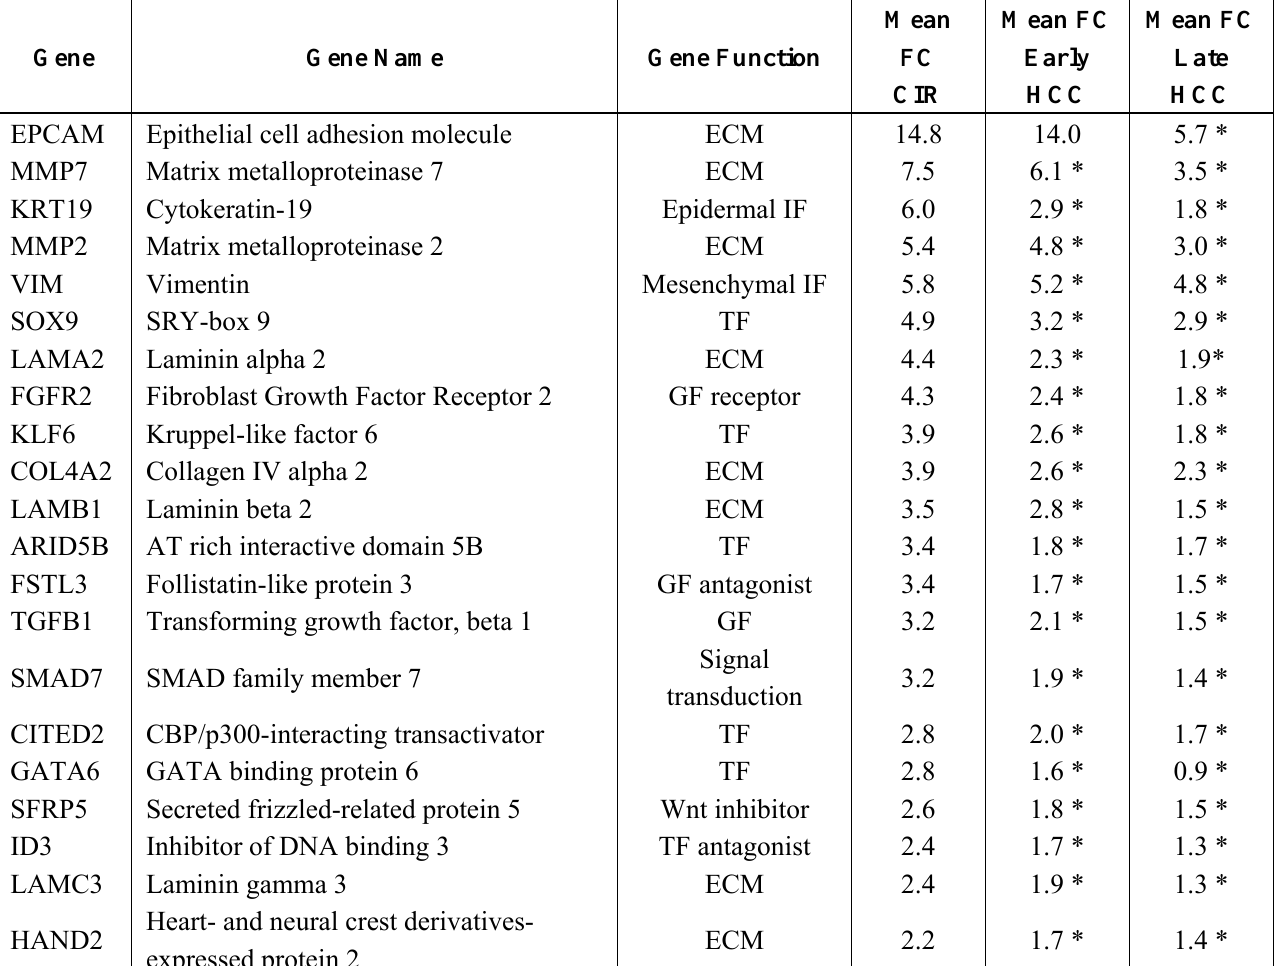
Table 1. Liver development genes with significantly higher expression in cirrhosis than tumor samples. Fold-changes are relative to normal